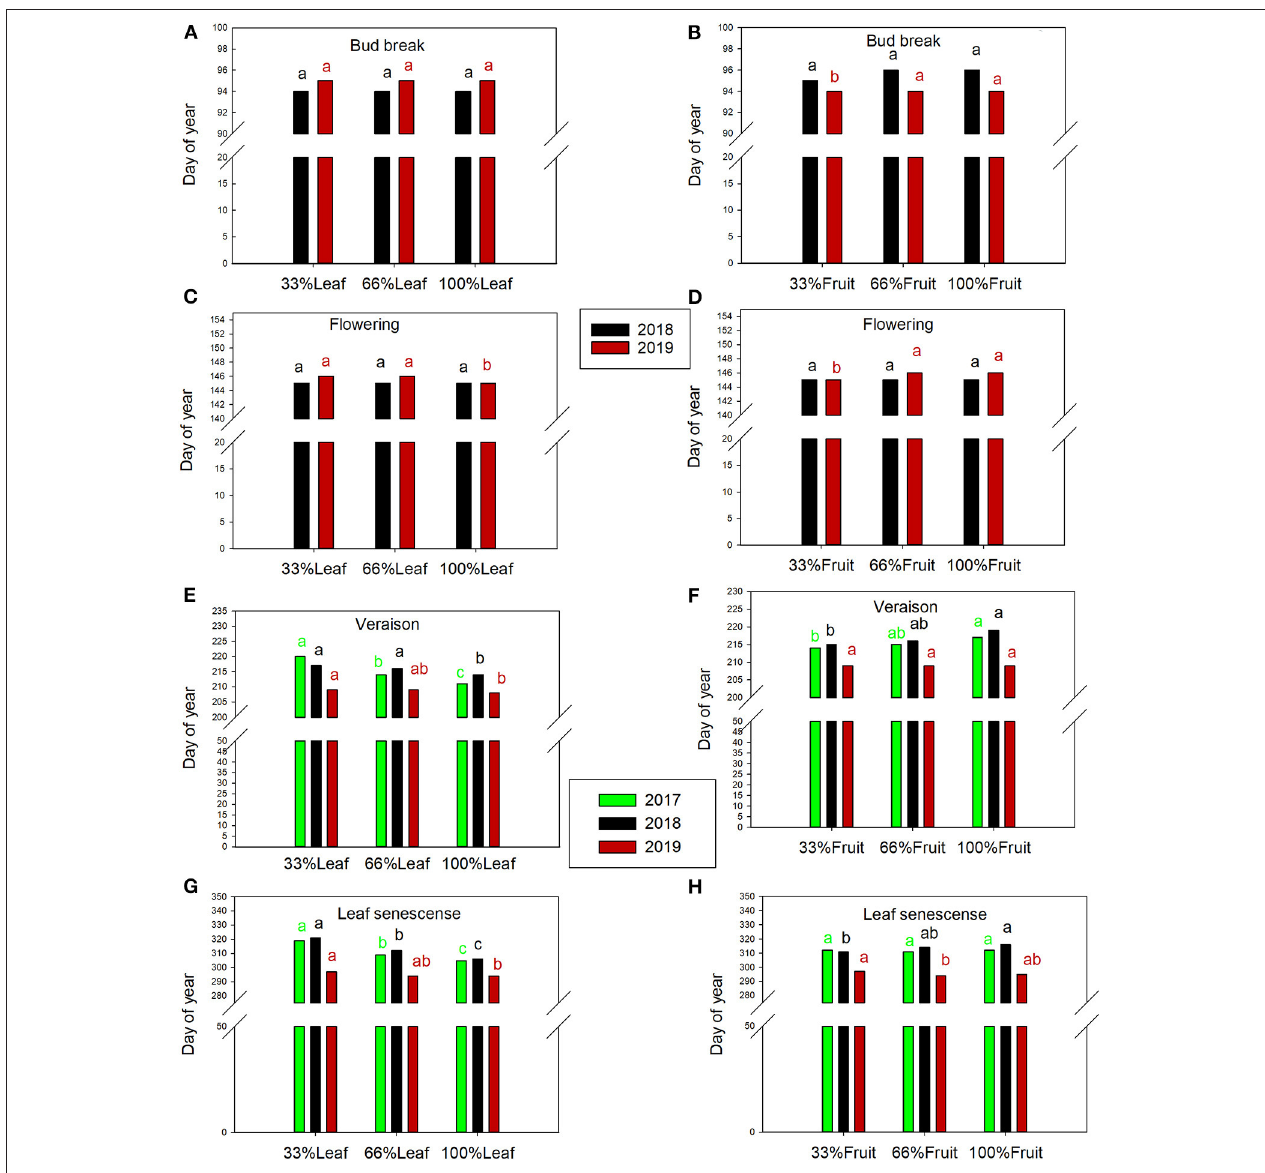
FIGURE 9 | Effect of defoliation and fruit removal main effects on bud break (A,B) , flowering (C,D) , veraison (E,F) and leaf senescence (G,H) of Cabernet Sauvignon grapevine in 2017, 2018, and 2019 (green, black and red columns, respectively). Columns with different letters indicated by the same color are significantly different according to Tukey’s HSD at P < 0.05. Interaction of defoliation and fruit removal not significant at either phenology measurement point in any